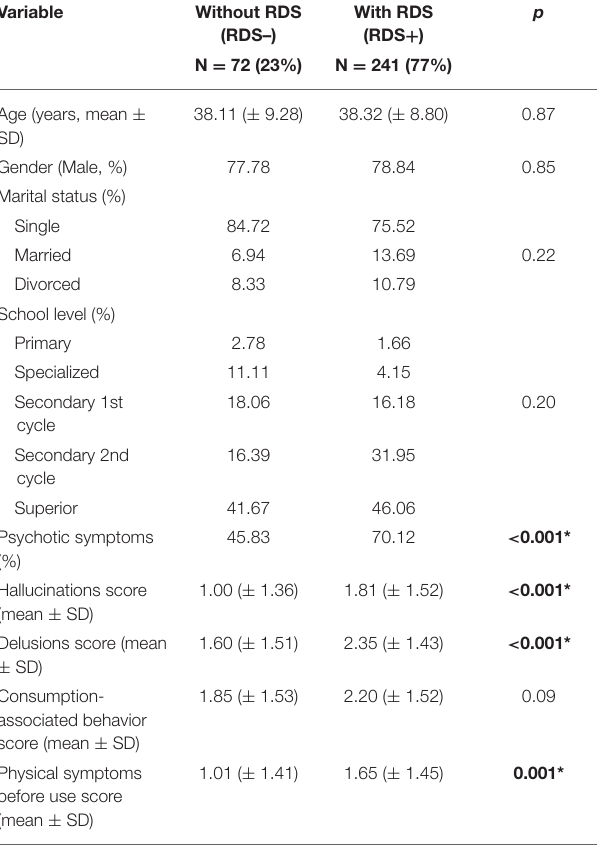
TABLE 2 | Clinical characteristics of cocaine users with (RDS + ) or without (RDS–) depressive symptoms during cocaine withdrawal ( N = 313). Variable Without RDS